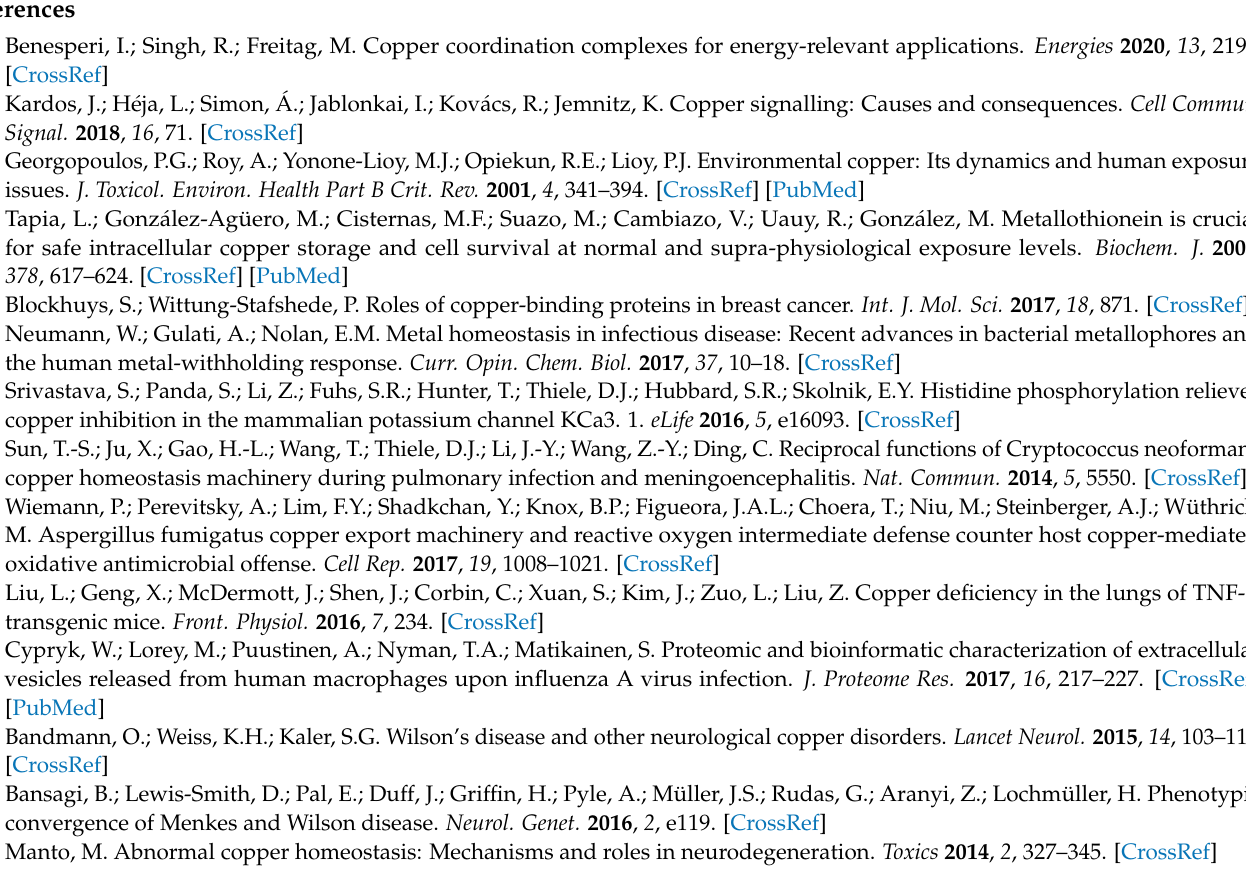
Table S2: Evaluation of cytotoxicity against HCT-116 cell line for [Cu 3 (L a ) 4 (Cl) 6 ] and Doxorubicin; Figure S1: FTIR spectra of the ligand L ; Figure S2: FTIR spectra of the trinuclear [Cu 3 (L a ) 4 (Cl) 6 ] complex; Figure S3: 1 H NMR Spectra of 2-(1-hydrazonoethyl)dihydrothiazole; Figure S4: 13 C NMR of 2-(1-hydrazonoethyl)dihydrothiazole; Figure S5: 1 H NMR Spectra of L ; Figure S6: 13 C NMR of L